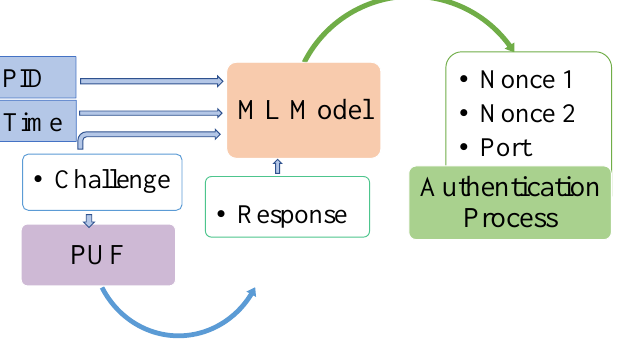
Figure 4. Overview of PUF and supervised SML based authentication